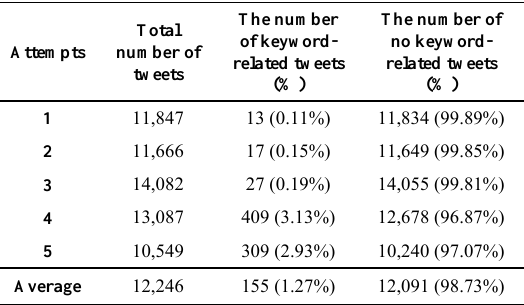
Table 2. Data gathering results from selecting an initial node by manual pick